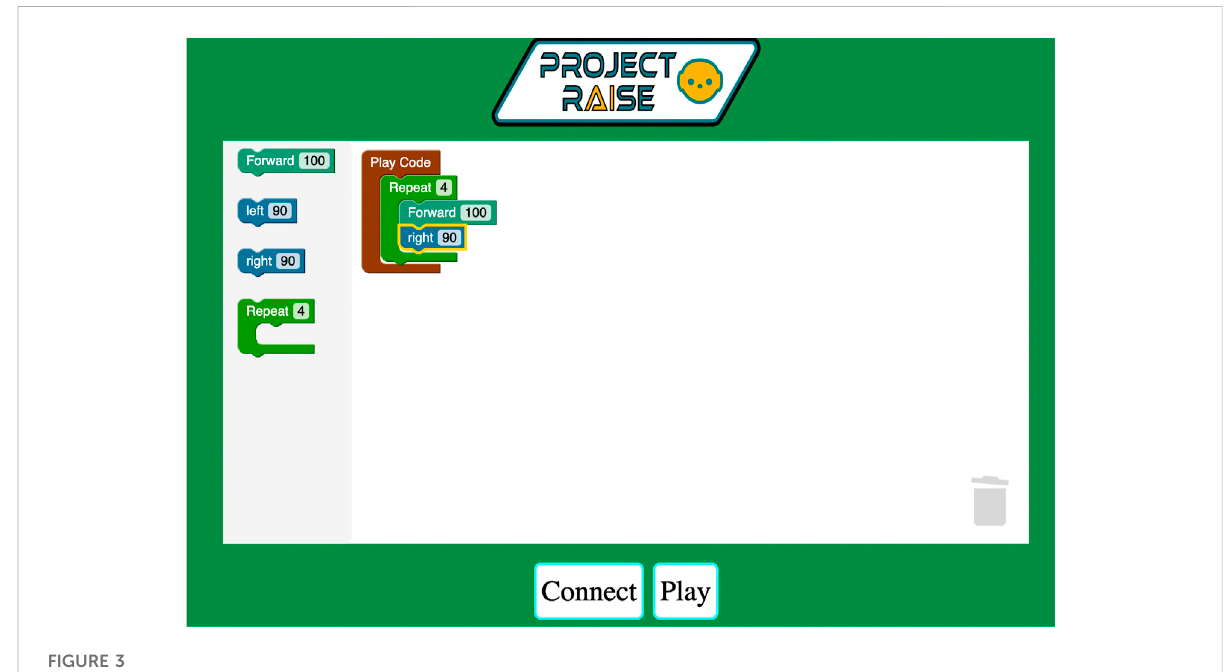
FIGURE 3 Traversing a right